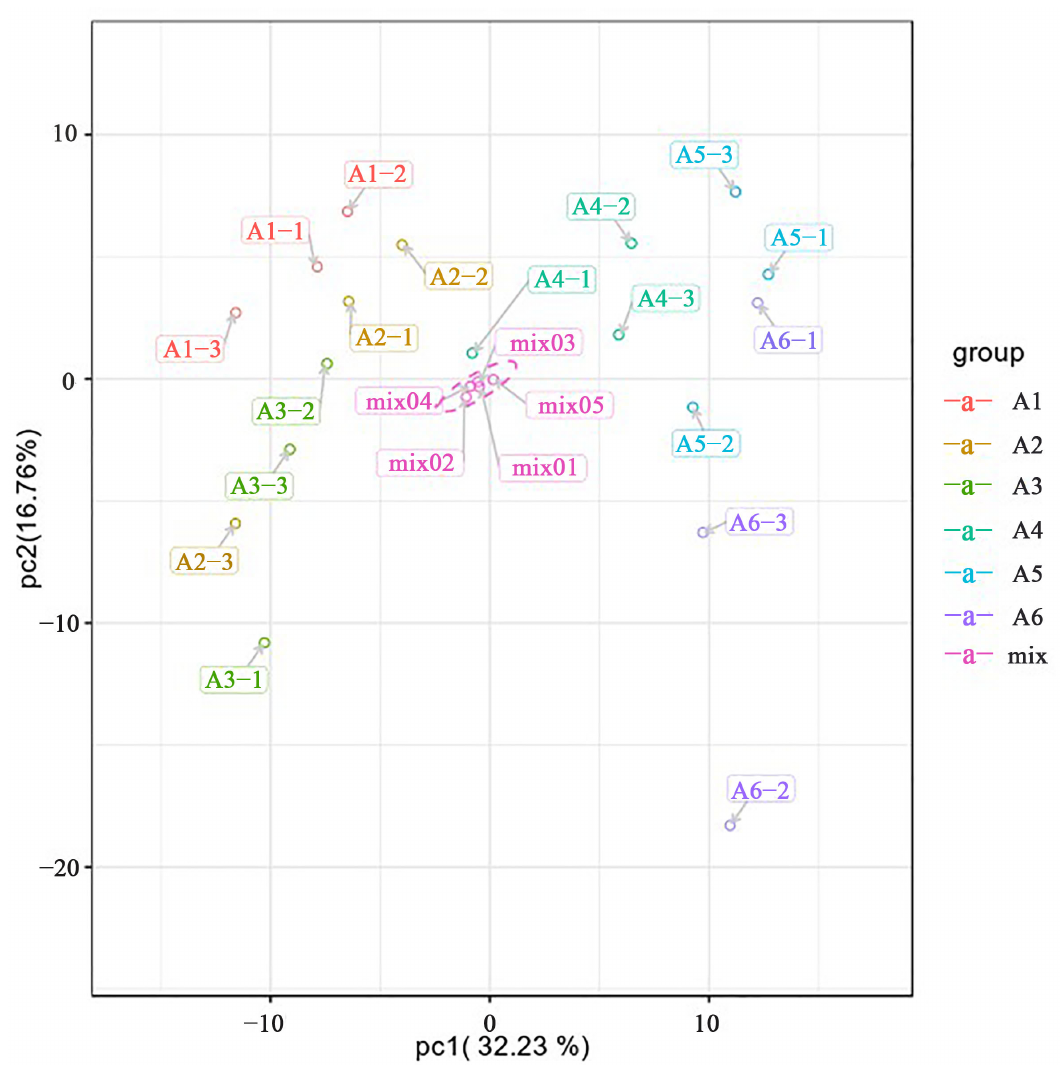
Figure 5. PCA scores of samples in each group and QC samples. The abscissa represents the first principal component and the ordinate represents the second principal component.